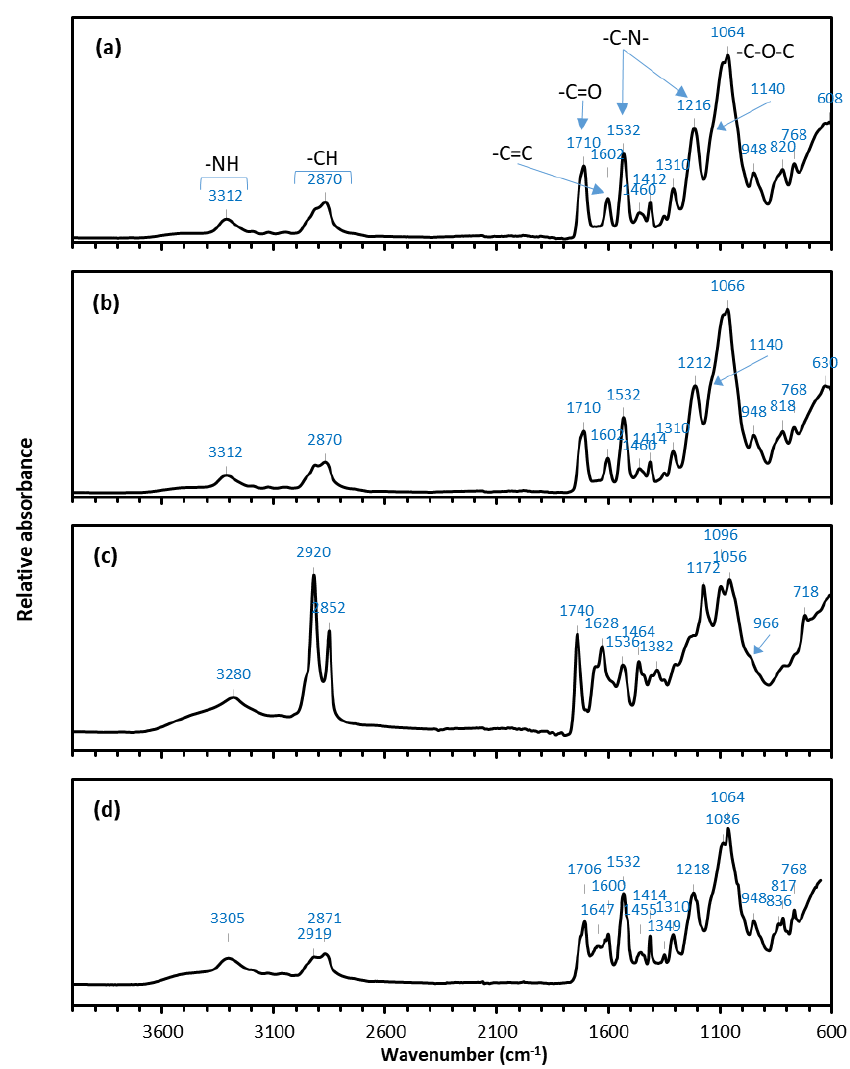
Figure 8. Fourier-transform infrared (FTIR) spectra of ( a ) unused PU-PTFE membrane sample; ( b ) PU-PTFE fouled during MD with MMF treated BStW2; ( c ) PU-PTFE fouled during MD with raw BStW1, and ( d ) PU-PTFE fouled during MD with raw FStW.